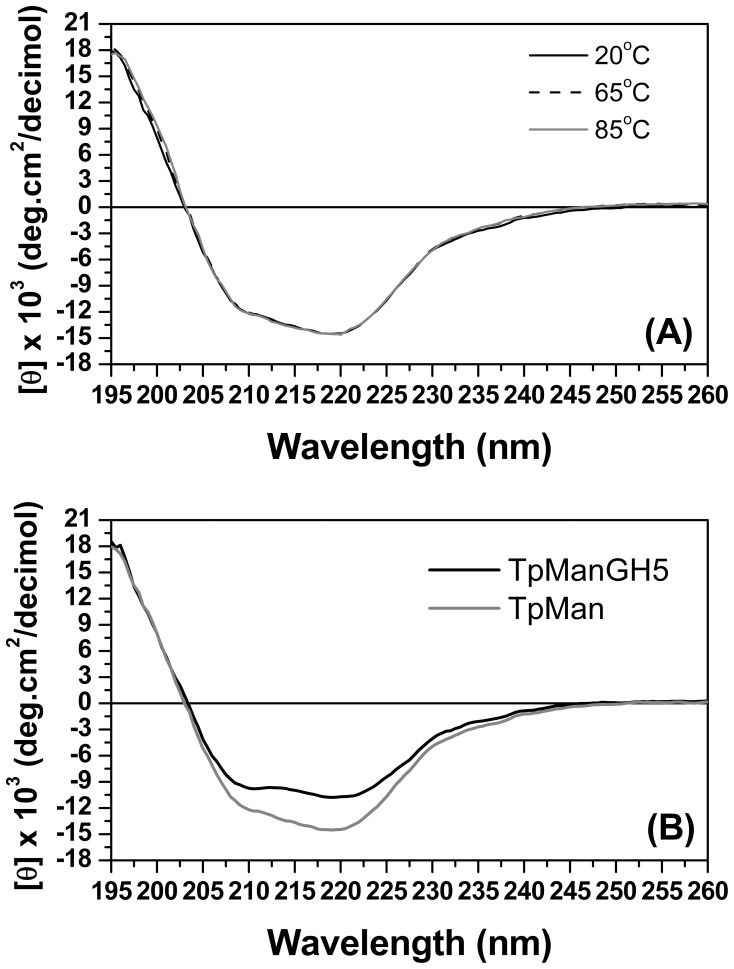
Circular dichroism spectroscopy.(A) CD spectrum collected for recombinant TpMan at 20°C (black solid line), 50°C (black dash line) and 85°C (gray solid line). (B) CD spectrum of TpManGH5 (black solid line) and TpMan (gray solid line) at pH 6 and 20°C.